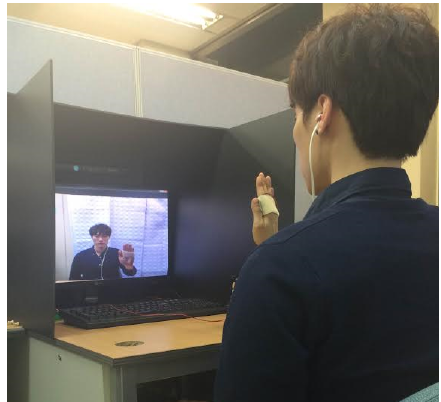
Figure 19. The experimental